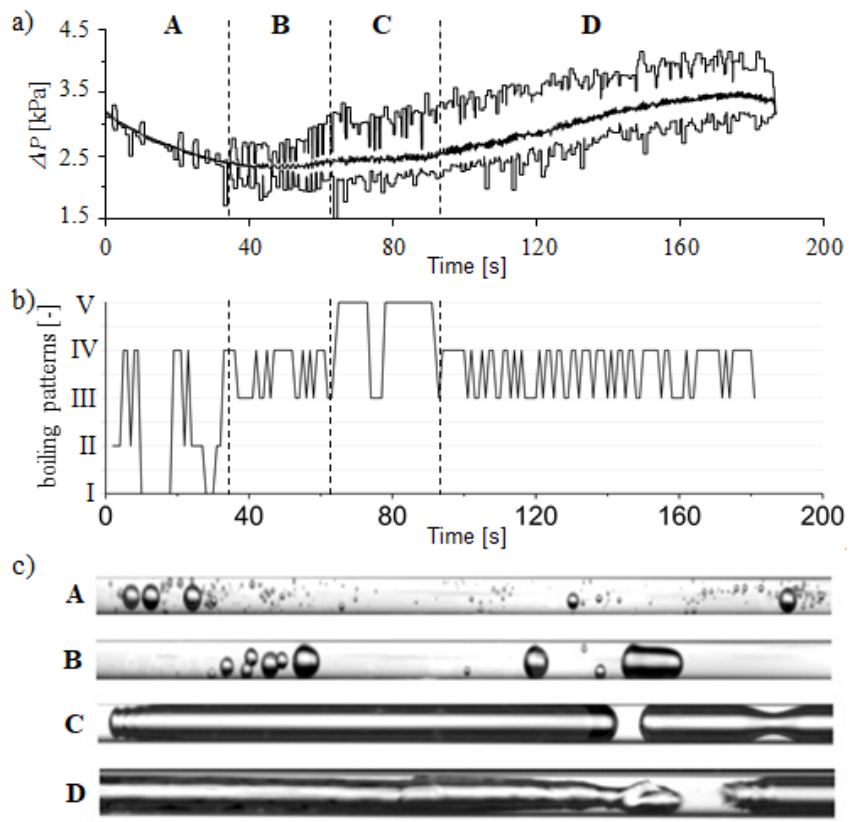
Figure 8. Boiling flow pattern oscillations and 4 boiling regimes during a single PDO cycle: ( a ) the maximum, minimum, and average values of the pressure drop oscillations; ( b ) the boiling flow pattern oscillations—results from the SOM analysis; ( c ) the example of two-phase flow patterns corresponding to distinguished boiling regimes.